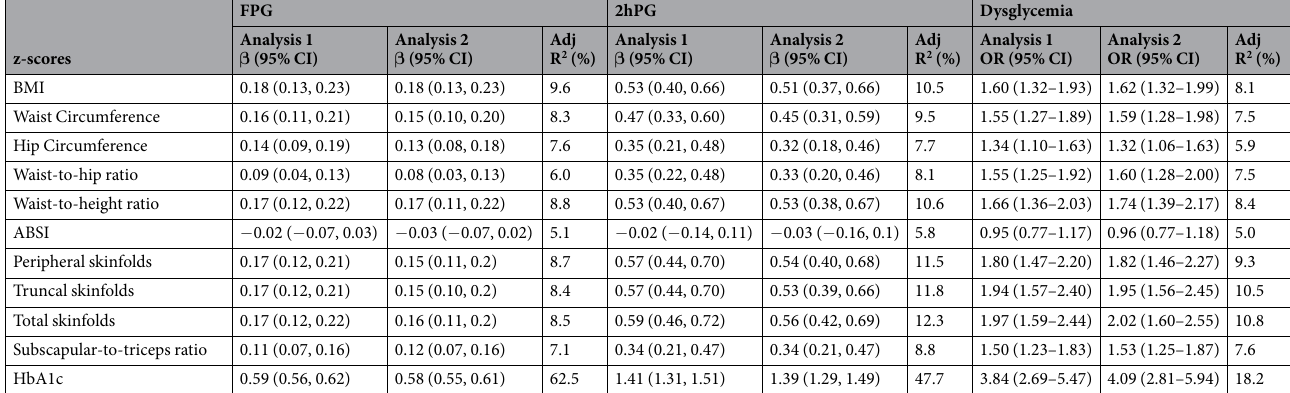
Table 2. Associations of anthropometric and HbA1c z-scores with glucose outcomes in reproductive age women. Regression estimates and odds ratios reflect a 1-SD increase in each index per mmol/L increment in glucose and with dysglycemia compared with normal glucose tolerance, respectively. Analysis 1: Adjusted for educational level and menstrual cycle regularity. Analysis 2: Adjusted for all covariates in Analysis 1; age, ethnicity, smoking history, shift work, parity, GDM history and family history of diabetes. Adjusted R 2 : Explained variance for Analysis 2. ABSI, A Body Shape Index; BMI, body mass index; CI, confidence interval; FPG, Fasting plasma glucose; HbA1c, glycated hemoglobin; OR, odds ratio; 2hPG, 2-hour plasma